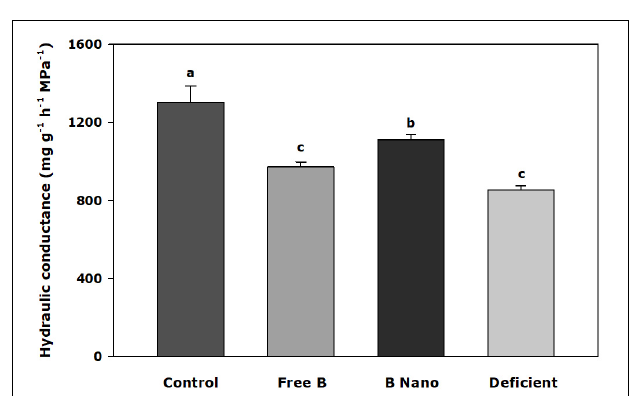
FIGURE 4 | Hydraulic conductance of the almond root 7 days after the foliar application of B. B Nano, Nanoencapsulated B. Values are means ± SE ( n = 8). Two independent experiments have been carried out. Columns with different letters differ significantly according to Duncan’s test ( p =